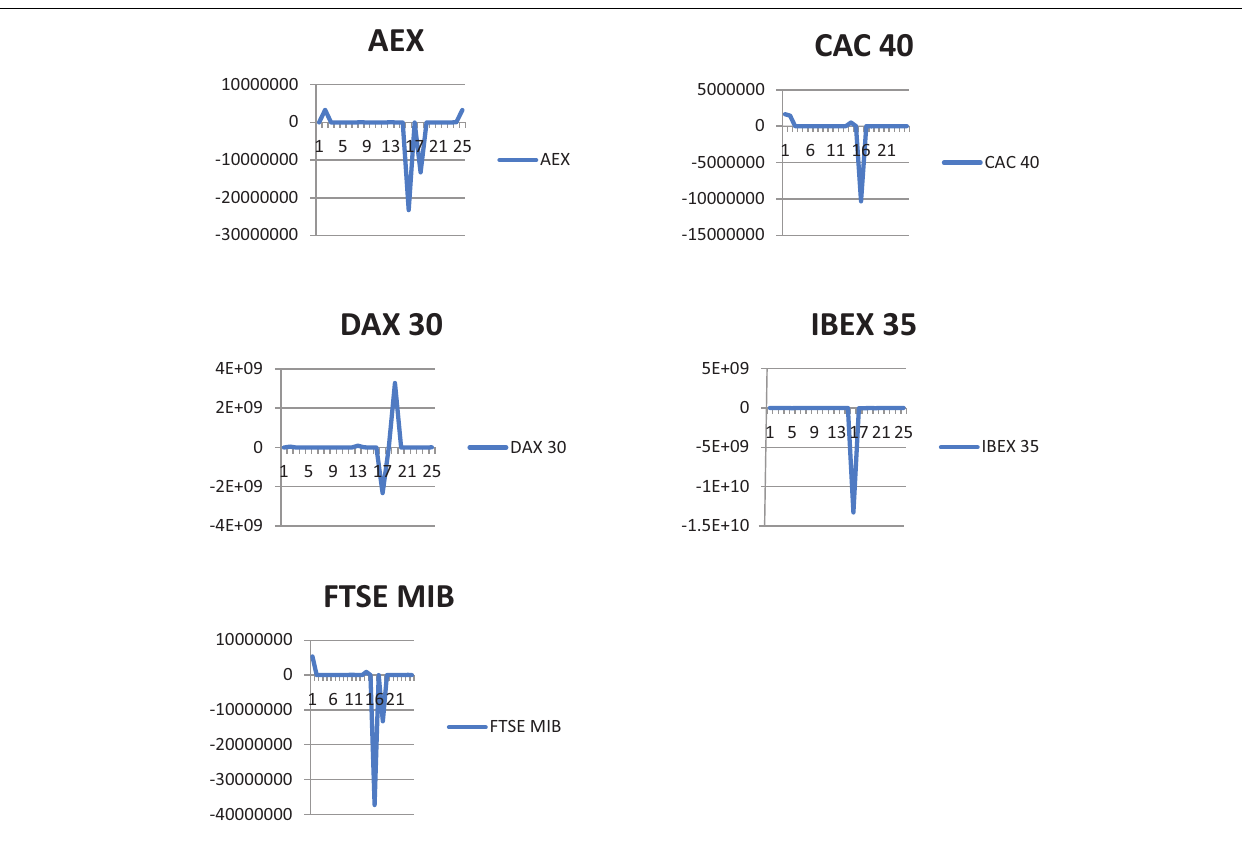
Frontiers in Psychology |